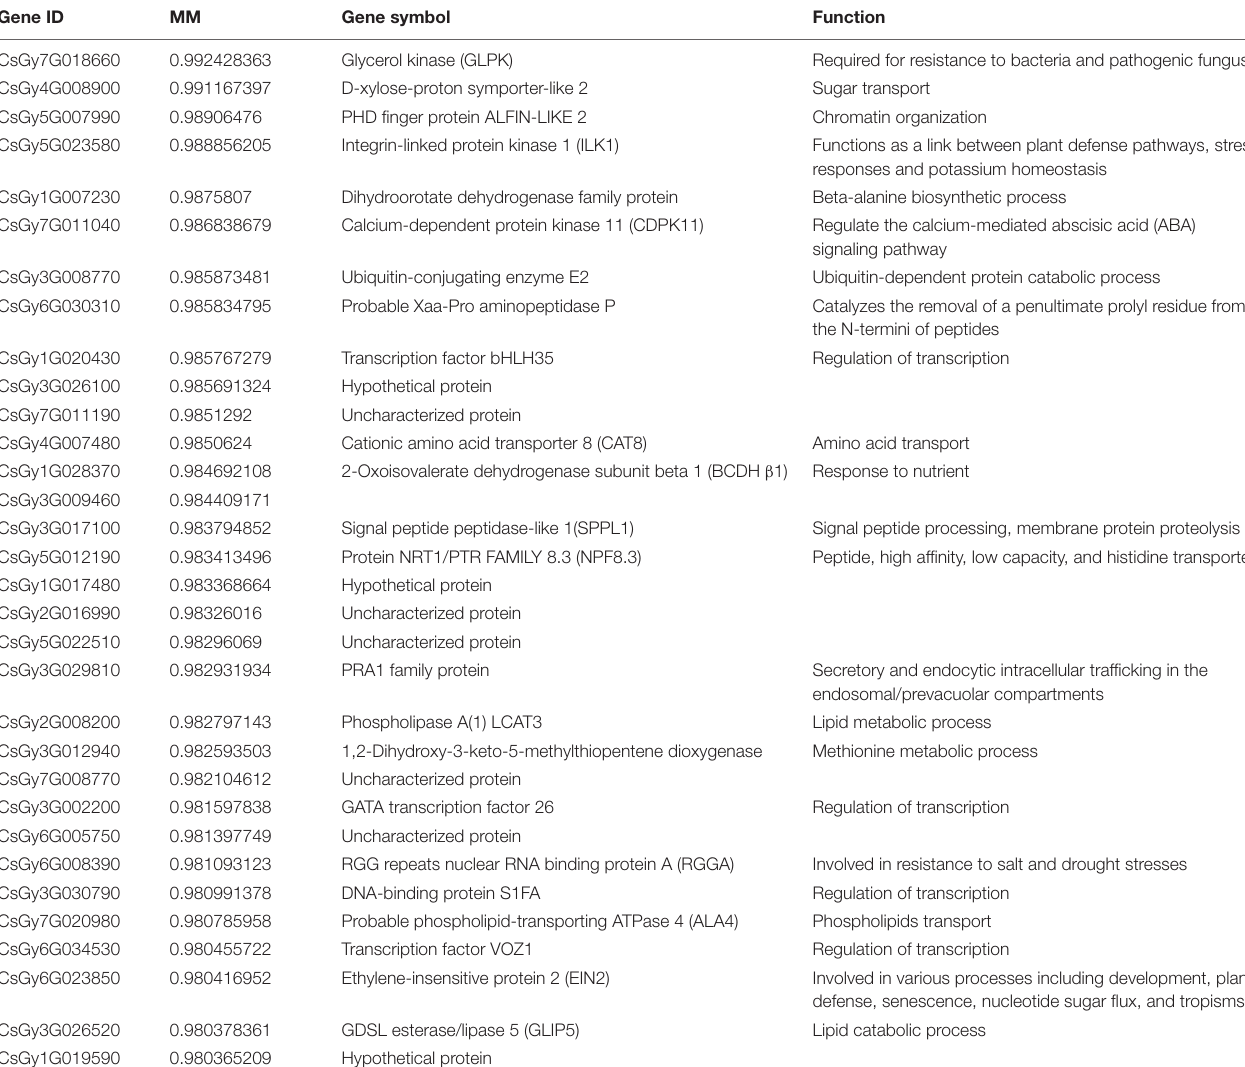
TABLE 2 | List of hub genes identified in the turquoise